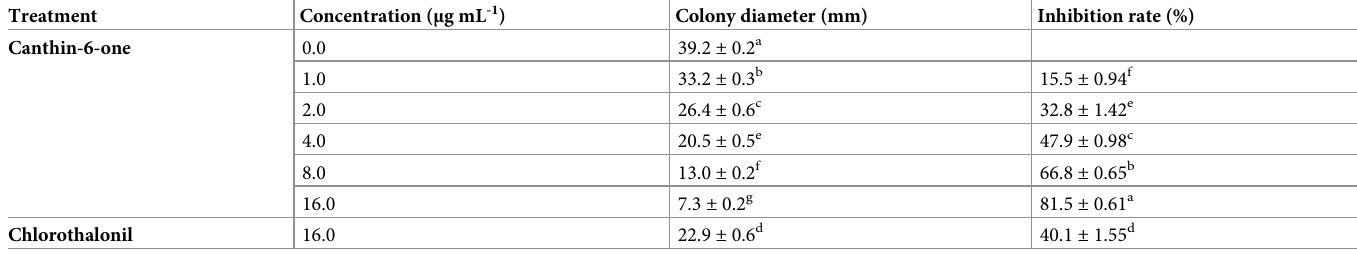
Table 1. Effect of canthin-6-one on mycelium growth.